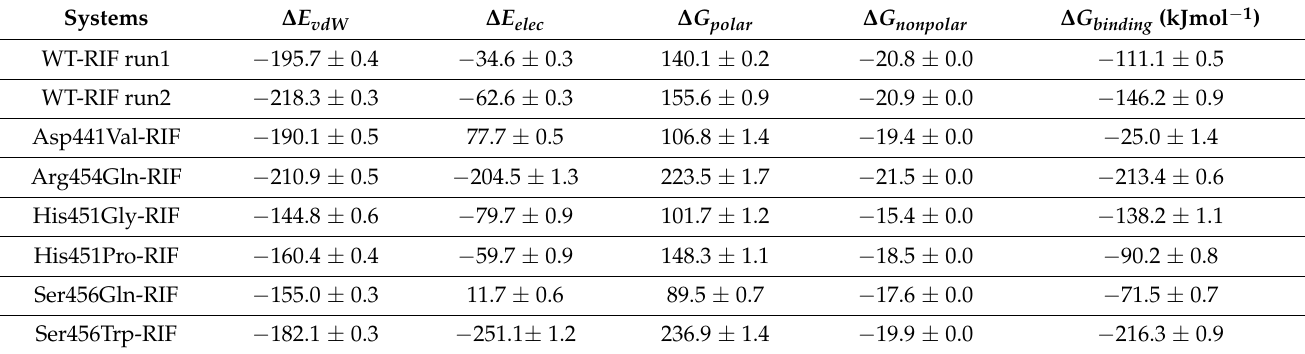
Table 1. Summary of binding free energy values acquired for each protein–ligand